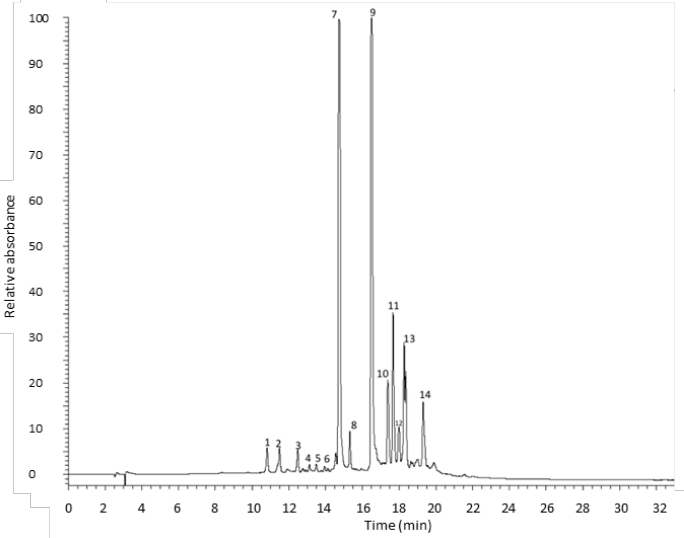
Figure 3. HPLC chromatogram of tunic A. cepa extract recorded at 370 nm.